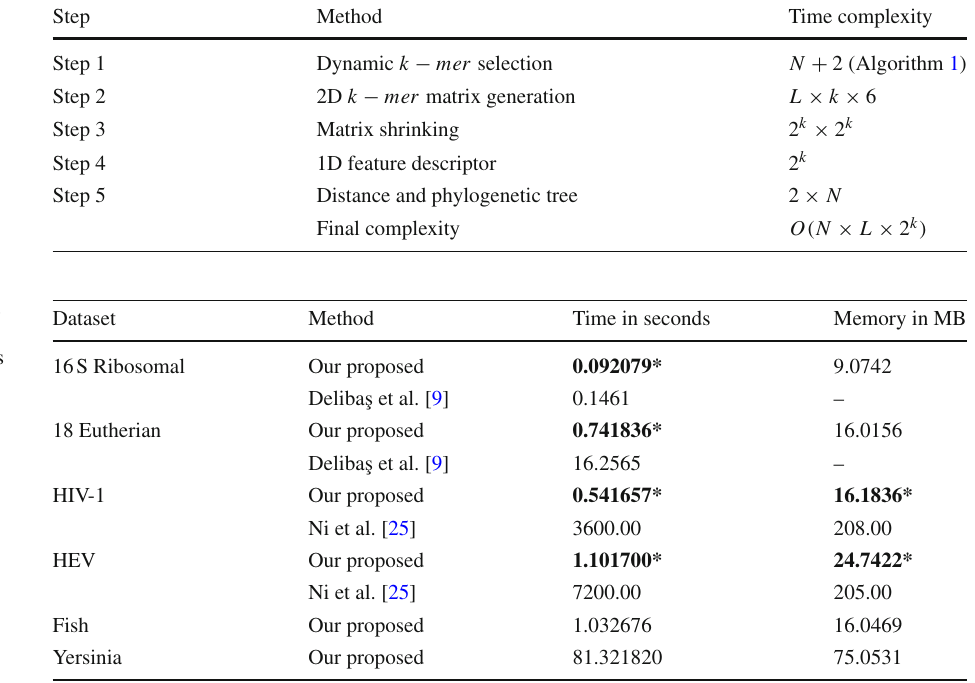
Table 10 Step-wise time complexity calculation for our proposed method